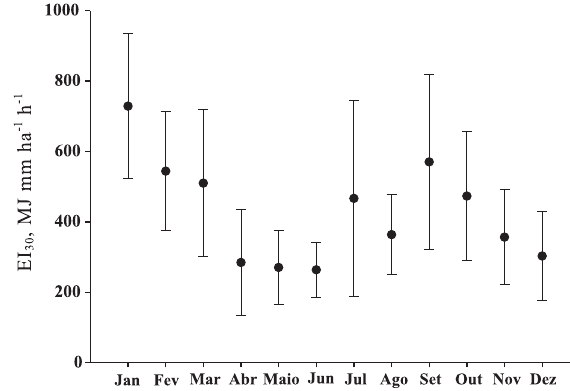
Figura 1. Distribuição média mensal do índice de erosividade (EI ) em Rio Grande-RS, no período 30 de 1957 a 1981, com intervalo de confiança de 95